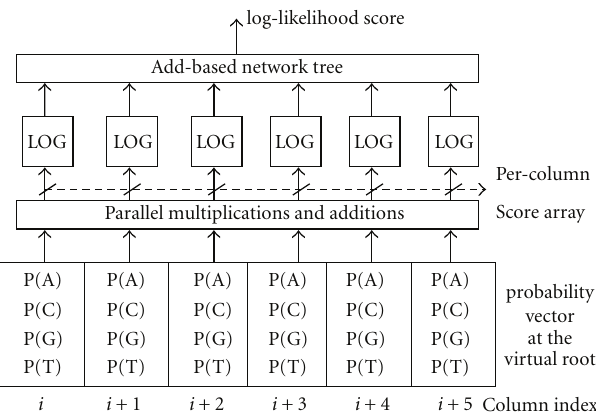
Figure 1: Parallel placement of logarithm units for the calculation of the log-likelihood score for a phylogenetic tree